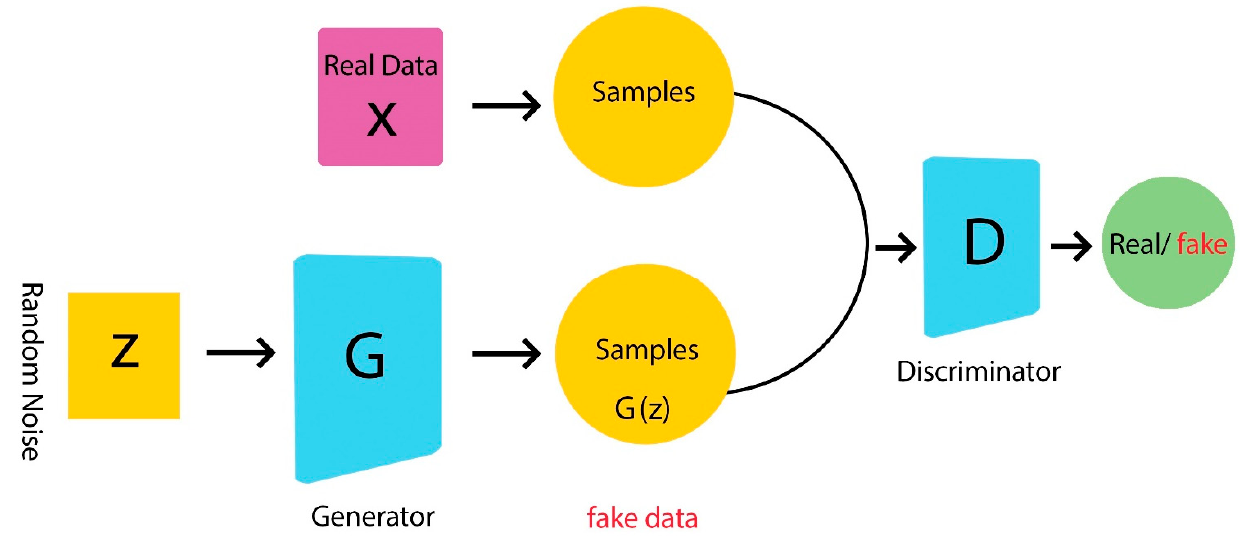
Figure 5. Generator and discriminator networks of the generative adversarial network.